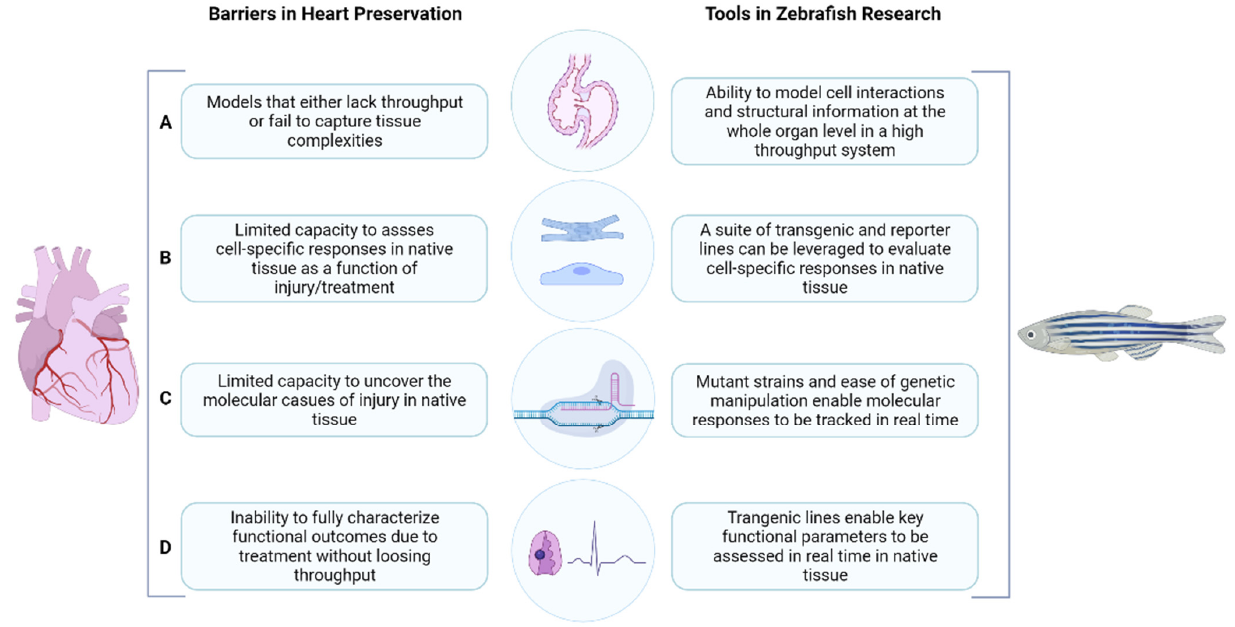
Figure 1. Summary of tools in zebrafish research and how they can help overcome barriers in heart preservation research. Isolated organ assessments ( A ); cell specific assessments ( B ); molecular assessments ( C ); functional assessments ( D ). Created with BioRender.com (accessed on 16 February